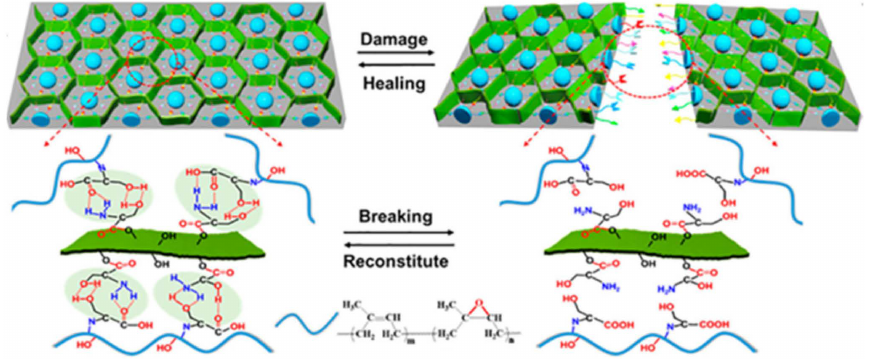
Figure5. DynamicbreakageandreconstitutionofinterfacialsupramolecularH-bondsinsupramolecular elastomer. Reprinted with permission from [115]. Copyright (2020) American Chemical Society.